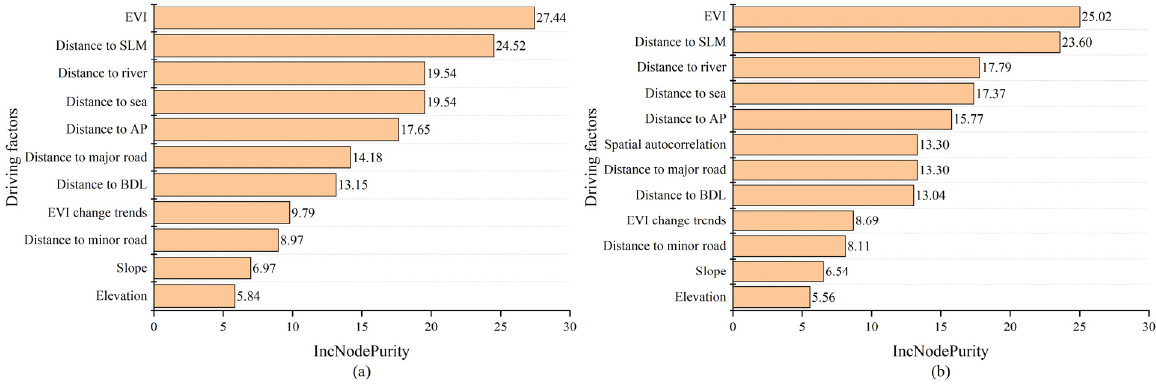
Figure 4. Applicability of driving factors in mangrove simulation. ( a ) RF; ( b )